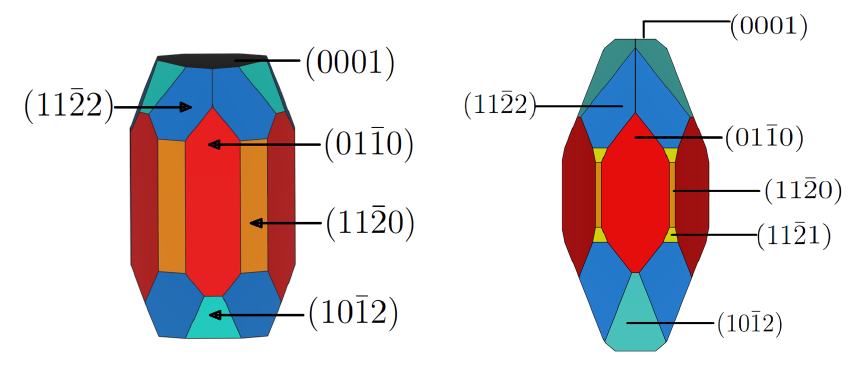
Figure 3. Equilibrium shape of the AlF 3 crystal ( left ) and AlCl x F 3 − x (ACF) ( right ) in a vacuum according to the Wulff scheme. For ACF, the most stable chloride substituted α -AlF 3 surfaces are regarded, namely ( 01¯10 ) , ( 11¯ 22 ) , ( 11 ¯ 20 ) , ( 0001 ) , ( 10 ¯12 ) and ( 11¯ 21 )